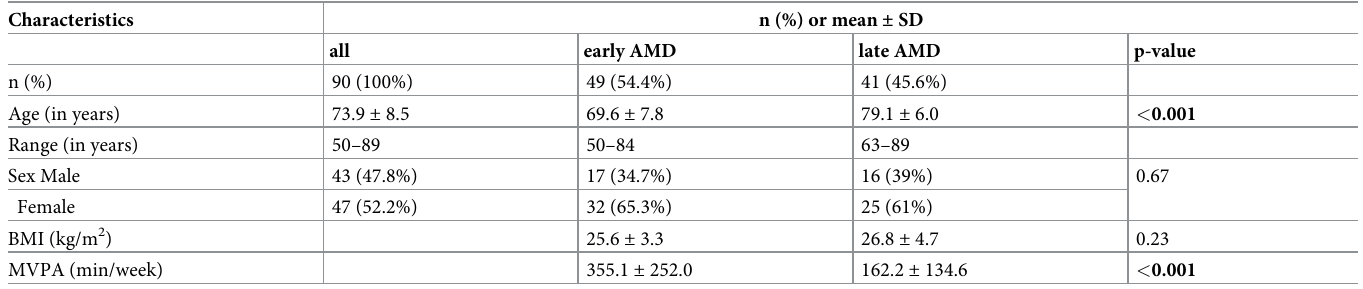
Table 1. Participant characteristics.